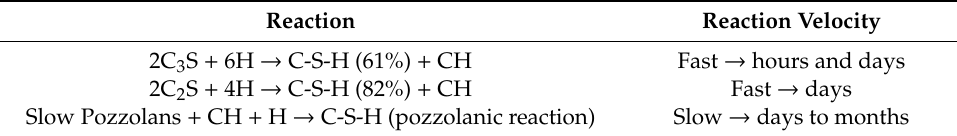
Table 1. Cement hydration and slow pozzolans reaction description, modified after Bezerra et al.